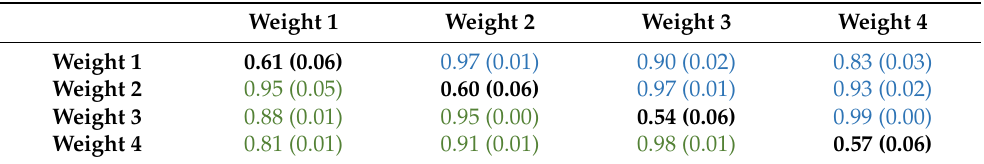
Table 4. Heritability (h 2 ) and genetic/phenotypic correlation for body weight using genomic rela- tionship matrix (GRM). Heritability is on the diagonal in bold; genetic and phenotypic correlations are above the diagonal (in blue) and below (in green), respectively. Standard errors are illustrated in the